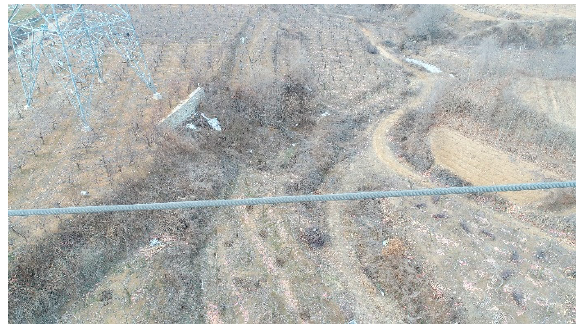
Figure 4. The LGJ-400/50 line.